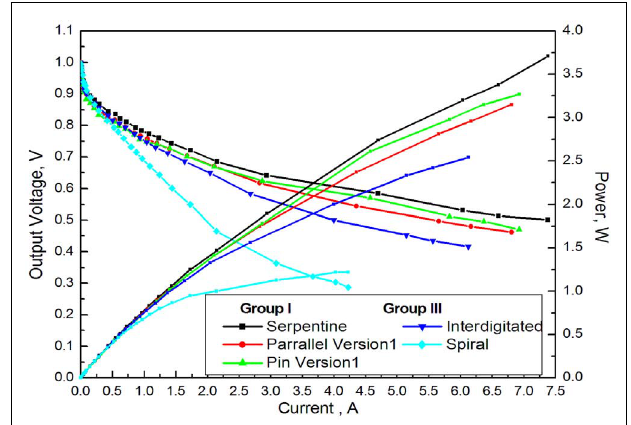
FIGURE 5 | Comparison of cell output performance between group I and group III flow field designs .